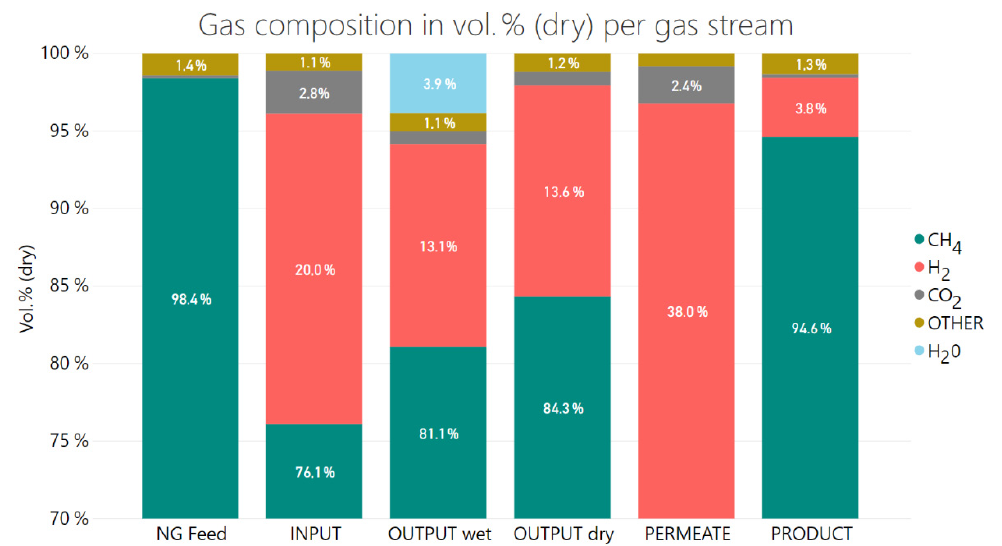
Figure 11. Gas composition per gas stream; all values in vol.-% (dry) for INPUT Case 2 (20% H 2 and 2.8% CO 2 ).